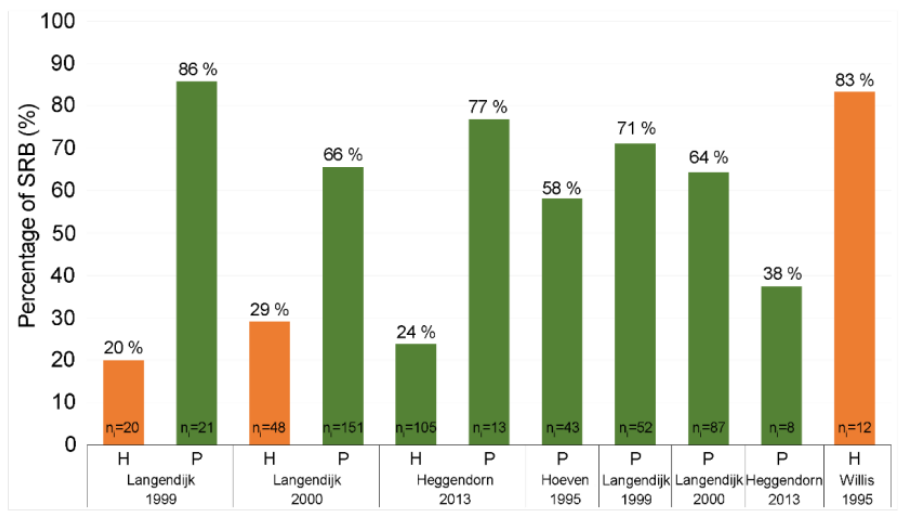
Figure 4. Comparison of the percentage of SRB in healthy people and patients with periodontitis. (H — healthy subjects; P — periodontitis; n i — number of individuals in sample)